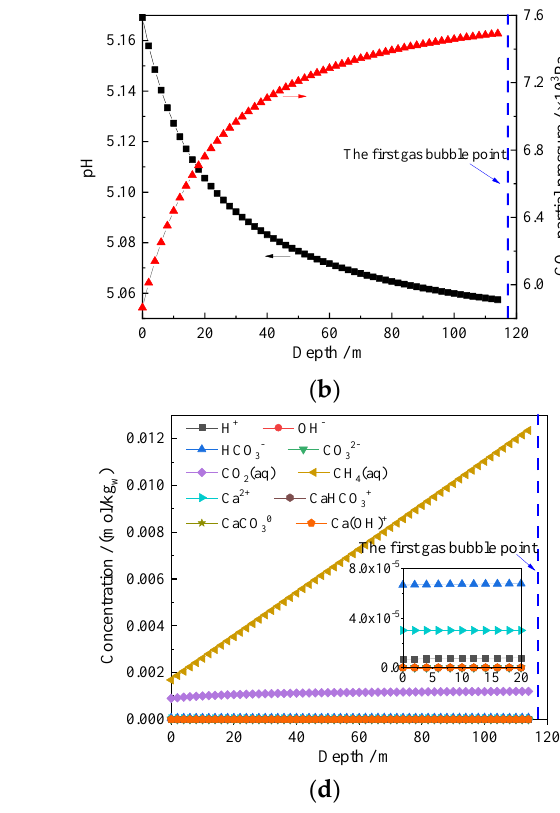
Note: the subscript aq refers to solution, g refers to gas phase. Figure 5 is the output data of the calculation example. Figure 5a shows the curves of temperature and pressure changes along the well. Figure 5b–d show evolutions of geothermal water pH, partial pressure of CO 2 and composition of gas and liquid phases after the first gas bubble point, respectively. Under a mass flow rate of 2.5 kg/s flow rate, the temperature decrease is small and the pressure decreases linearly. After the first gas bubble point, due to the escape of CO 2 , the pH of geothermal water increases exponentially and the partial pressure of CO 2 decreases rapidly. These curve evolution trends match the calcite scaling mechanism very well. The change in gas composition in Figure 5c shows that CH 4 gas has a faster growth rate than CO 2 , because CH 4 has a lower solubility in water. Figure 5d shows the change in concentration of each component in the liquid phase. It can be seen that, except for free CO 2 molecules, CH 4 molecules, HCO 3− and Ca 2+ , the concentration of other components in the solution is low, less than 1 × 10 −5 mol/kg w . In other words, calculated parameters changed significantly after the first gas bubble point, while they were almost unchanged before the first gas bubble point, except for the total pressure.